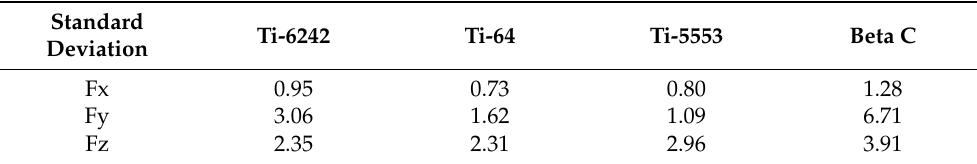
Table 3. Standard deviation on the Fx, Fy and Fz forces measured in the bulk alloy regions in Multi -FAST